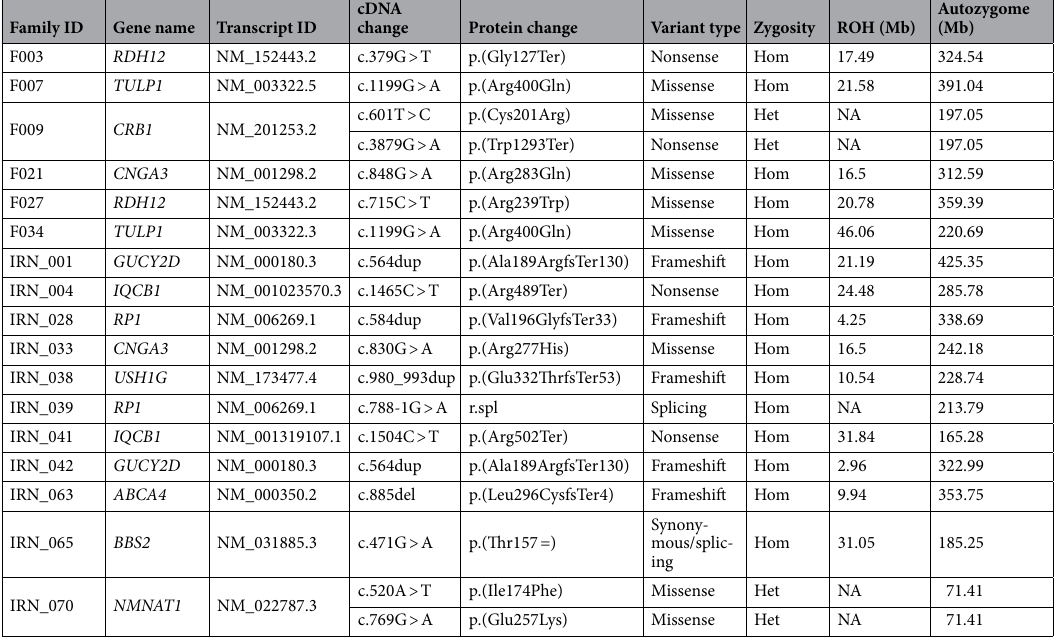
Table 1. List of genetic variants identified in 17 Iranian families. Hom homozygous, Het heterozygous, ROH runs of homozygosity, NA not available, Mb